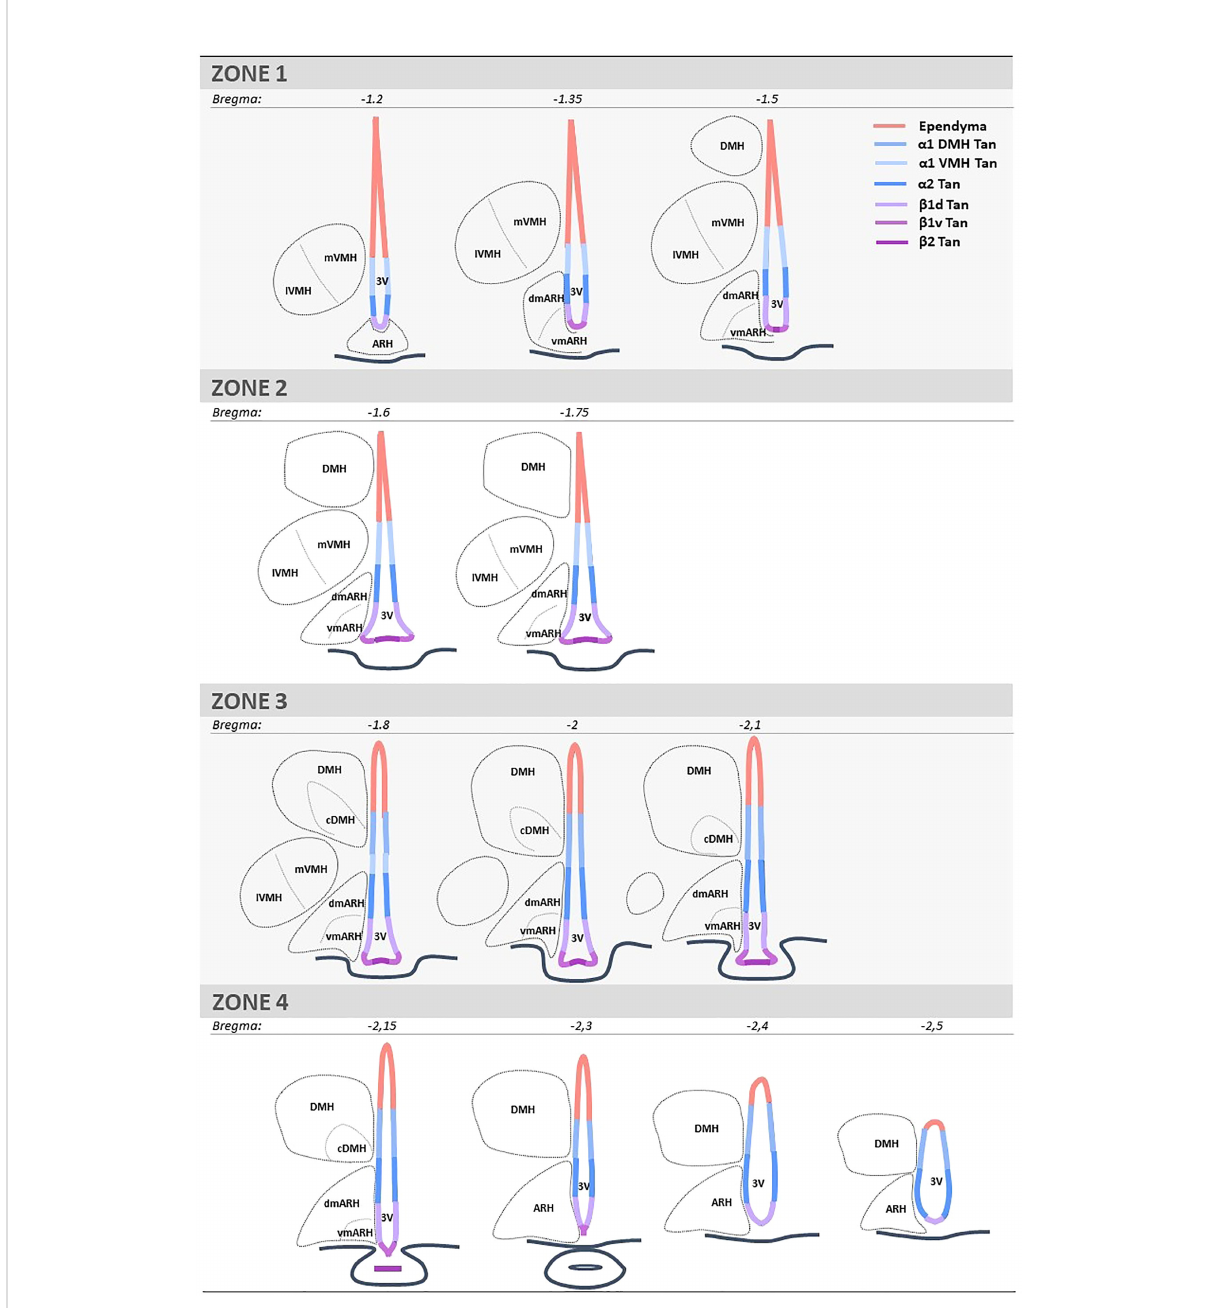
FIGURE 1 Schematic representation and coordinates of the four consecutive rostrocaudal zones used to analyze the mediobasal hypothalamus. Zone 1 corresponds to the anterior part of the ARH and the ME, where tanycyte processes are mainly found in the ARH and a few in the VMH. Zone 2 corresponds to the medial part of ME, where the bottom of the ventricle is more considerable, and tanycyte processes are found in both the ARH and VMH. Zone 3 corresponds to the medial-posterior part of the ME, where the VMH is lateral, and tanycyte processes are now observed in the DMH. Zone 4 corresponds to the posterior part of the ME and the presence of the infundibular stalk, where tanycyte processes are sent in the ARH and DMH. ARH is subdivided into vmARH and dmARH. VMH is subdivided into mVMH and lVMH. DMH is subdivided into cDMH. The ependyma is subdivided into 7 subregions: the ependymal layer facing the medial ME for beta-2 tanycytes ( b 2 Tan), the lateral ME for ventral beta-1 tanycytes ( b 1v Tan), the vmARH for dorsal beta-1 tanycytes ( b 1d Tan), the dmARH for alpha-2 tanycytes ( a 2 Tan), the VMH for rostral alpha-1 tanycytes ( a 1 VMH Tan), the cDMH for caudal alpha-1 tanycytes ( a 1 DMH Tan), and the dorsal part of the DMH for typical ependymal cells. 3V, third ventricle; ARH, arcuate nucleus of the hypothalamus; cDMH, compact dorsomedial nucleus of the hypothalamus; dmARH, dorsomedial arcuate nucleus of the hypothalamus; DMH, dorsomedial nucleus of the hypothalamus; lVMH, lateral ventromedial nucleus of the hypothalamus; ME, median eminence; mVMH, medial ventromedial nucleus of the hypothalamus; vmARH, ventromedial arcuate nucleus of the